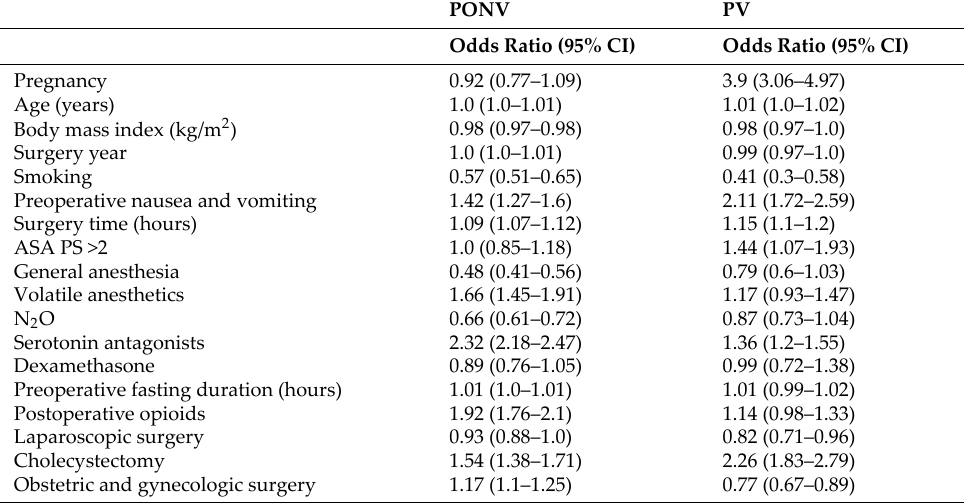
Table A2. Adjusted odds ratio of all variables for developing PONV and PV in reproductive female patients who underwent nondelivery